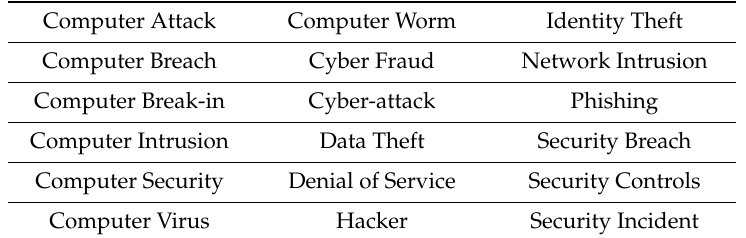
Table 3. The keywords used for searching news on information security